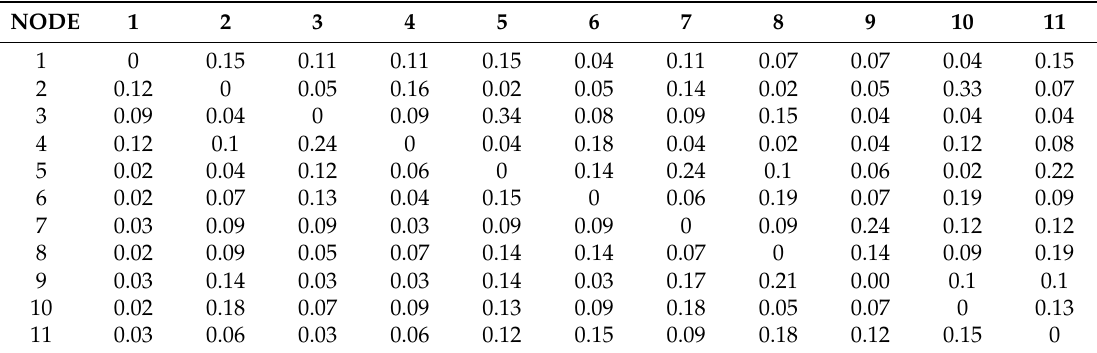
Table A1. Real Madrid’s matrix of state out-transition probabilities.